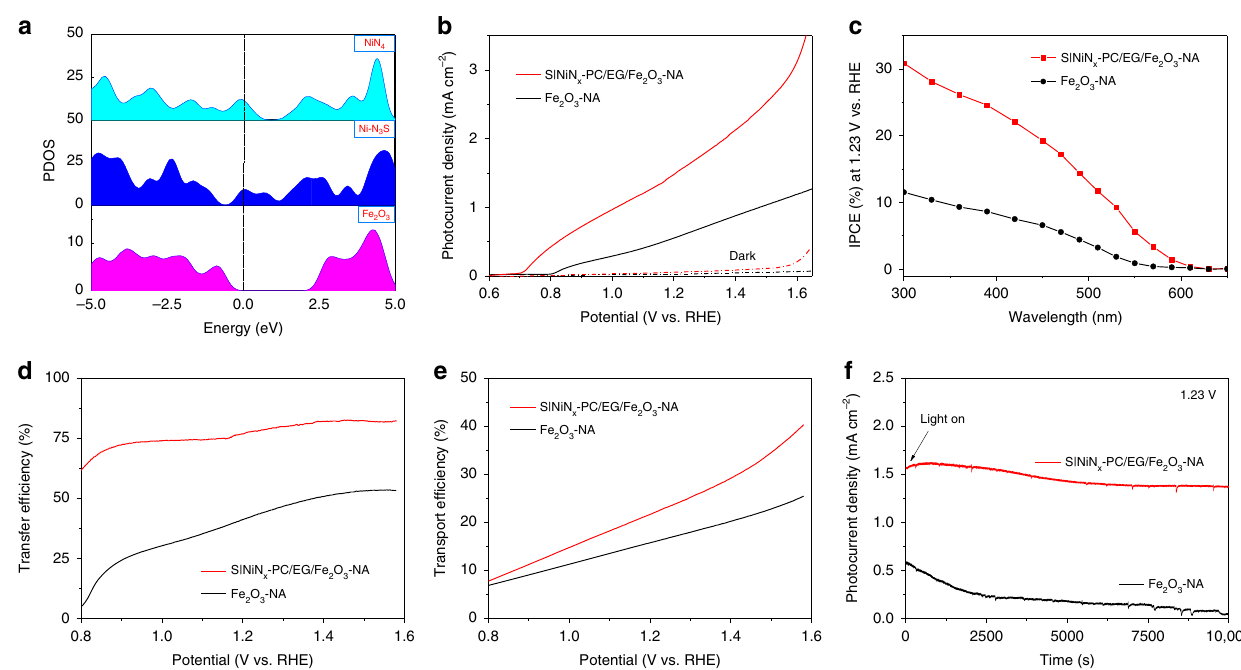
Fig. 5 PEC-OER performance. a DFT-calculated projected density-of-states for the Ni − N 4 , Ni − N 3 S, and Fe 2 O 3 models. b Variation in the photocurrent density vs. applied voltage for Fe 2 O 3 -NA and S|NiN x − PC/EG/Fe 2 O 3 -NA under dark and AM 1.5G irradiation. c IPCE spectra of Fe 2 O 3 -NA and S|NiN x − PC/ EG/Fe 2 O 3 -NA under AM 1.5G irradiation. d , e Charge-transfer ef fi ciencies and charge transport ef fi ciencies of Fe 2 O 3 -NA and S|NiN x − PC/EG/Fe 2 O 3 -NA. f Transient photocurrent responses of Fe 2 O 3 -NA and S|NiN x − PC/EG/Fe 2 O 3 -NA under AM 1.5G irradiation at 1.23 V. All experiments were carried out in 1.0 M